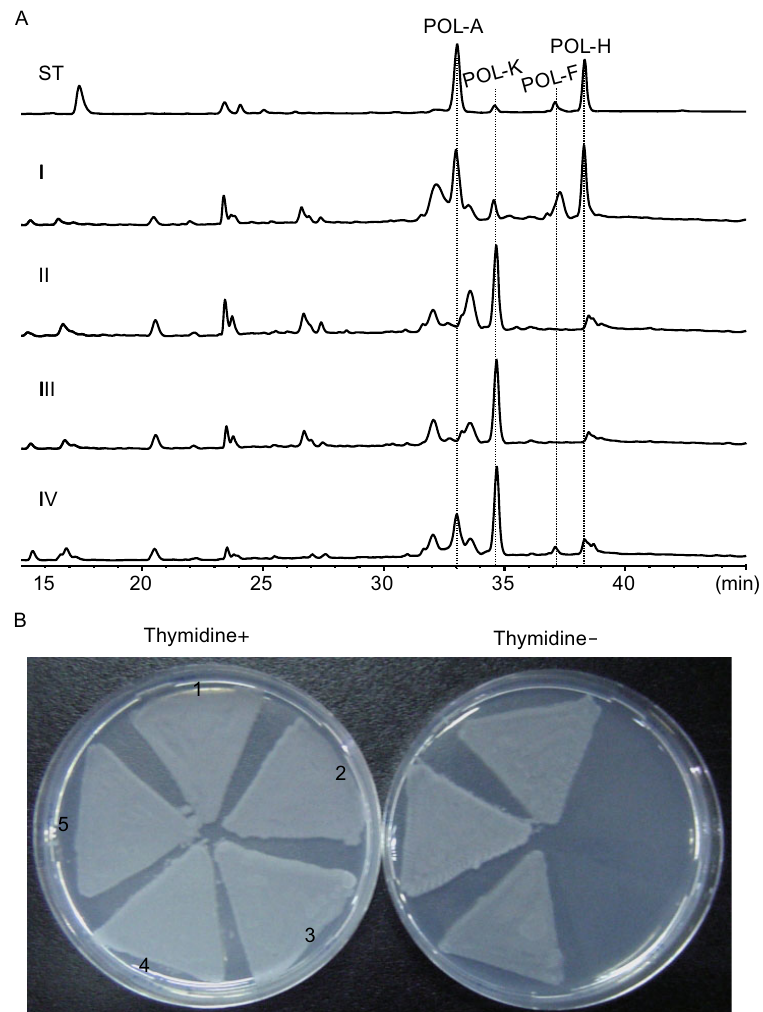
Figure 2. Genetic characterization of the polB function. (A) HPLC pro fi les of the metabolites produced by wild-type and mutant S. cacaoi strains. ST, polyoxin authentic standards; I, metabolites from wild-type S. cacaoi ; II, metabolites from CY5; III, metabolites from CY5 containing pIB139 as negative control; IV, metabolites from CY5 complemented by polB . (B) polB is capable of restoring growth phenotype for the thyX mutant of S. cacaoi . 1: CY5; 2: CY6, the thyX and polB double mutant of S. cacaoi ; 3: CY6/pIB139, CY6 containing pIB139 as negative control; 4: CY6/ polB , CY6 complemented by polB ; 5: CY6/ thyX , CY6 complemented by thyX . The left plate contains thymidine, whereas which is absent in the right